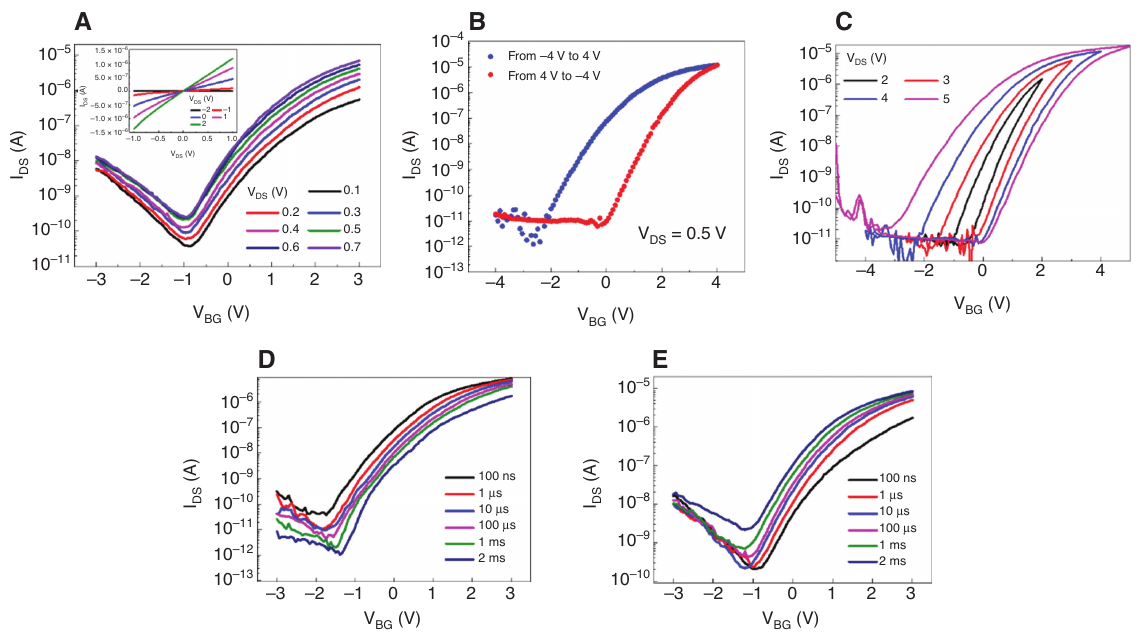
CTM device. 2 transistor. I as a function of V with V varying from 0.1 to 0.7 V with 0.1-V step. Inset: I 2 DS BG DS swept from −1 to + 1 V. (B) I –V hysteresis curves of the MoS CTM device under −4 V to + 4 V V DS DS BG 2 –V hysteresis curves of the MoS CTM device in different V DS BG 2 CTM device in different programming time at + 4 V gate voltage 2 CTM device in different erasing time at −4 V gate voltage pulse 2